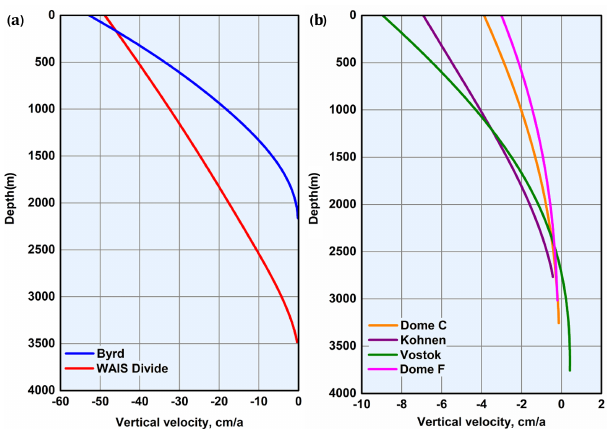
Figure 5. Estimated vertical velocities at drilling sites in West Antarctica (a) and East Antarctica (b) . In East Antarctica snow ac- cumulation and thus vertical ice velocities are far less than in West